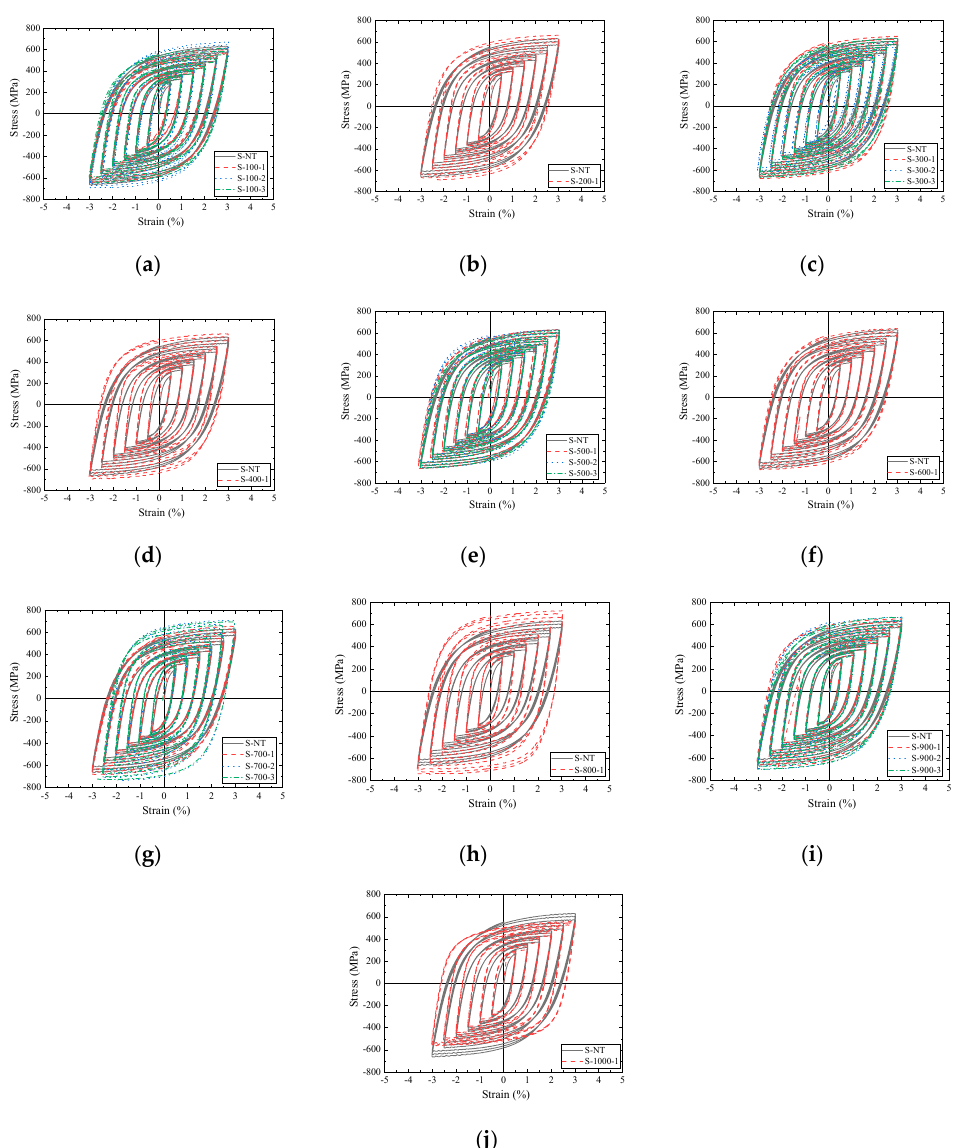
Figure 13. Hysteretic curves of S304. ( a ) 100 °C; ( b ) 200 °C; ( c ) 300 °C; ( d ) 400 °C; ( e ) 500 °C; ( f ) 600 °C; ( g ) 700 °C; ( h ) 800 °C; ( i ) 900 °C; ( j ) 1000 °C.